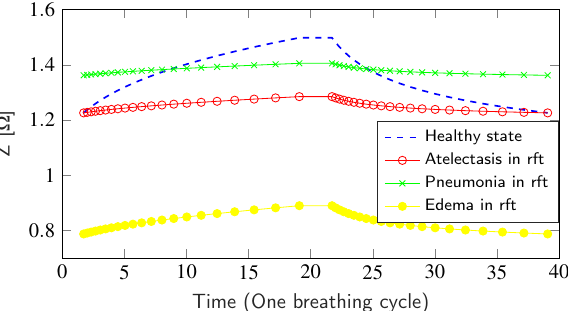
(b) Impact of the different simulated pathologies on the measurement result during a breathing cycle. Measurements were focused on the rft region. In blue, the healthy state is shown. Atelectasis is simulated in red, pneumonia in green and edema in yellow.